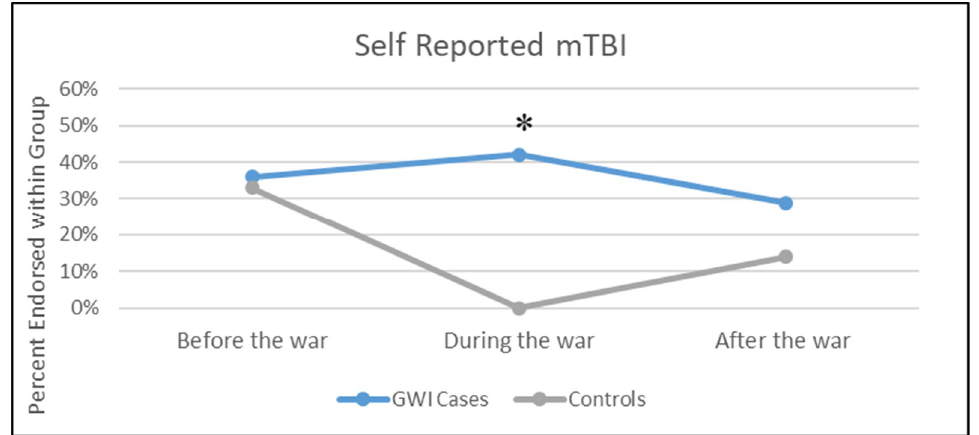
Figure 1. Percent of veterans with self-reported mTBI before, during, and after the war. * p < 0.005.